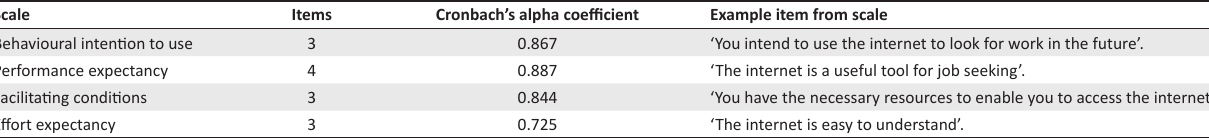
TABLE 1: Cronbach’s alpha coefficients of instrument used for this research. Scale Items Cronbach’s alpha